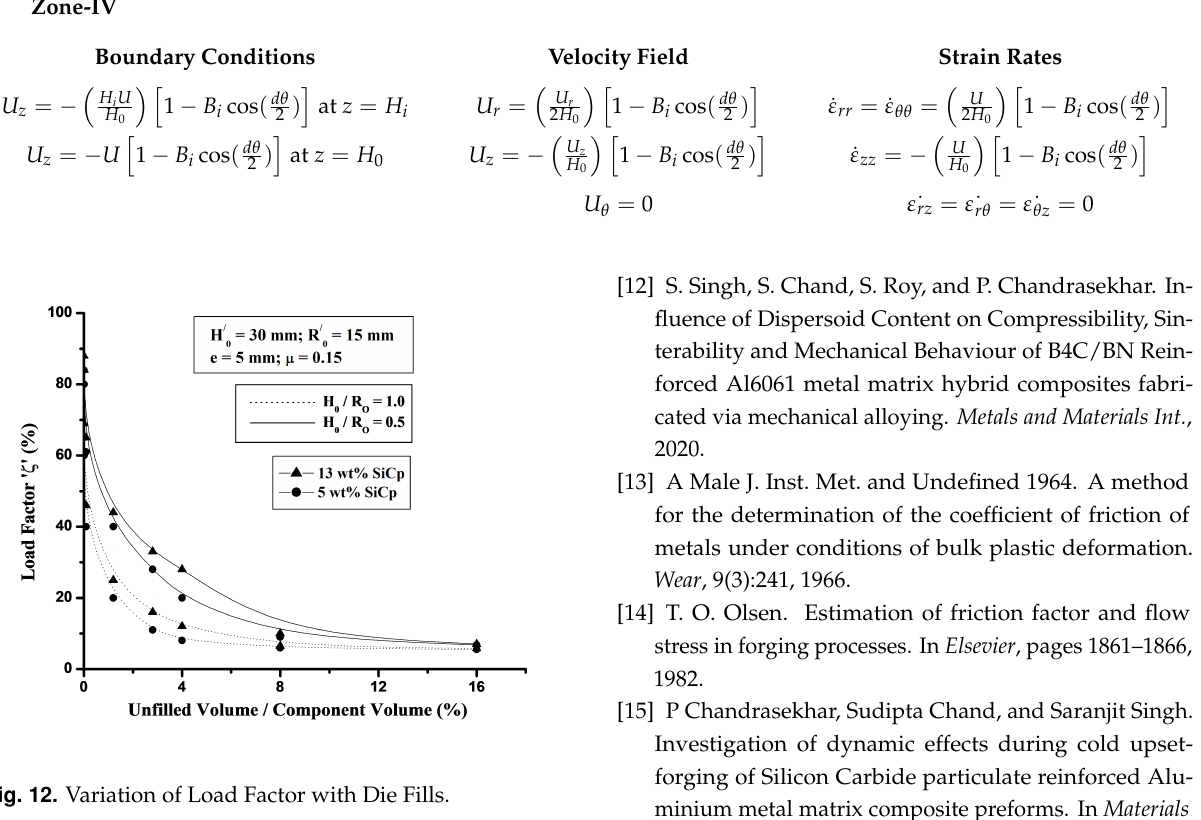
Fig. 12. Variation of Load Factor with Die